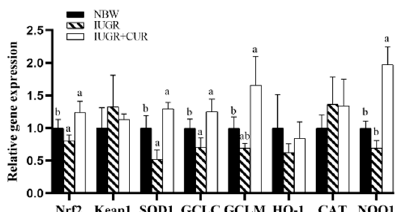
Figure 1. Effects of curcumin on antioxidant-related gene expression: NF-E2-related factor 2 ( Nrf2 ), kelch like ECH associated protein 1 ( Keap1 ), superoxide dismutase 1 ( SOD1 ), glutamate-cysteine ligase catalytic subunit ( GCLC ), glutamate-cysteine ligase modifier subunit ( GCLM ), heme oxygenase-1 ( HO-1 ), catalase ( CAT ) and NAD(P)H quinone dehydrogenase 1 ( NQO1 ) in jejunal mucosa. Data are normalized to the normal-birth weight (NBW) group and expressed as mean ± SE (n = 6); a, b means that the same parameter with different superscripts are significantly different ( p < 0.05).